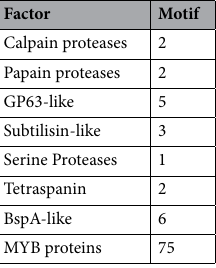
Table 3. Number of factors analyzed in this work with motifs in their predicted